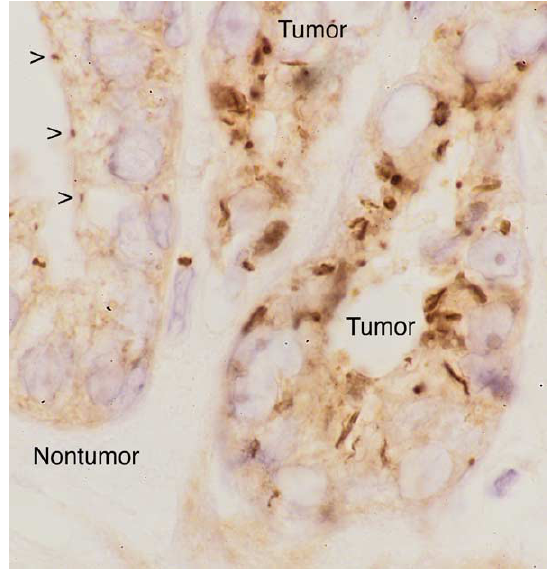
Fig. 4. Centrosomes are abnormal in size, shape and number in hu- man prostate tumors. Abnormal centrosomes in a prostate tumor (right, brown) compared with normal centrosomes in nontumor cells (left, arrowheads). Tissue section stained by immunoperoxidase for the centrosome protein pericentrin and for hematoxylin and eosin. Note consistent size of centrosome in nontumor cells and abnormal centrosome numbers, shapes and sizes in tumor